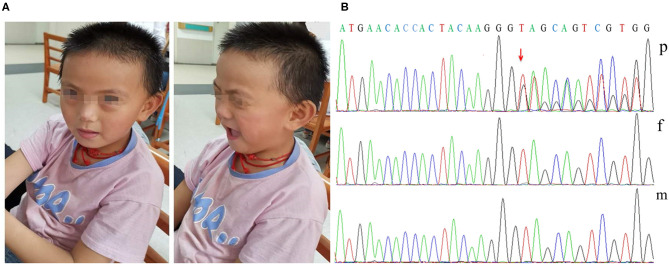
Dysmorphic features and variant analysis. (A) Photographs of our patient at 7 years and 5 months showing brachycephaly, a flat face, a thin upper lip, and low-set ears. (B) The proband had the c.1745dupG variant of DDX3X (p), leading to a premature stop codon; however, her parents had no detectable variants (f and m).